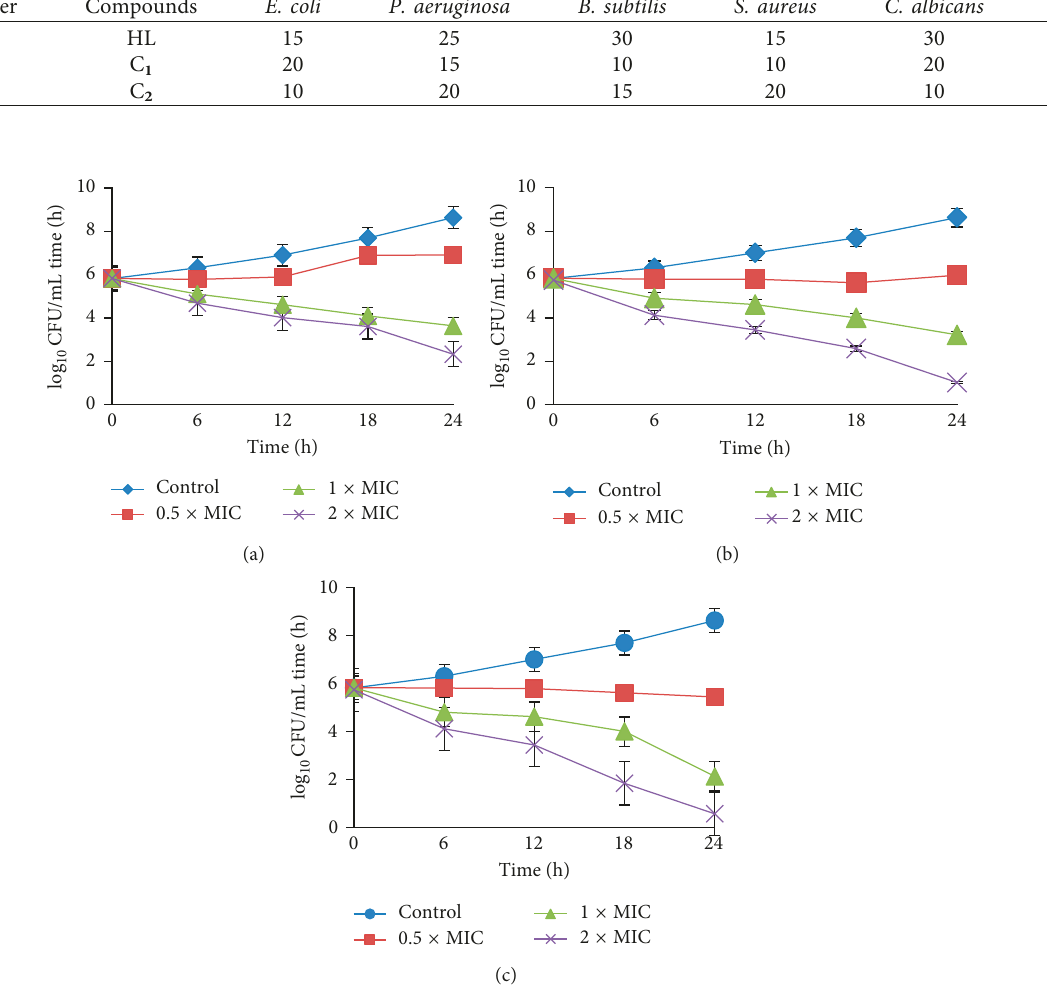
1 , and (c) C 2 on E. coli after exposure to 0.5 × , 1 × , and 2 × the MIC